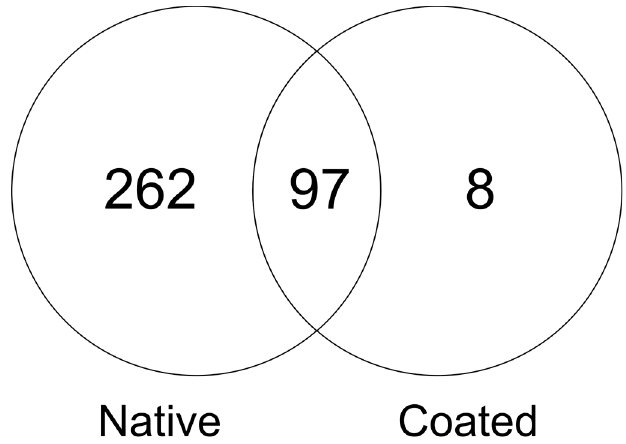
Figure 4. Venn diagram comparing the number of proteins identified uniquely on native surfaces, uniquely on coated surfaces, and on both surfaces.